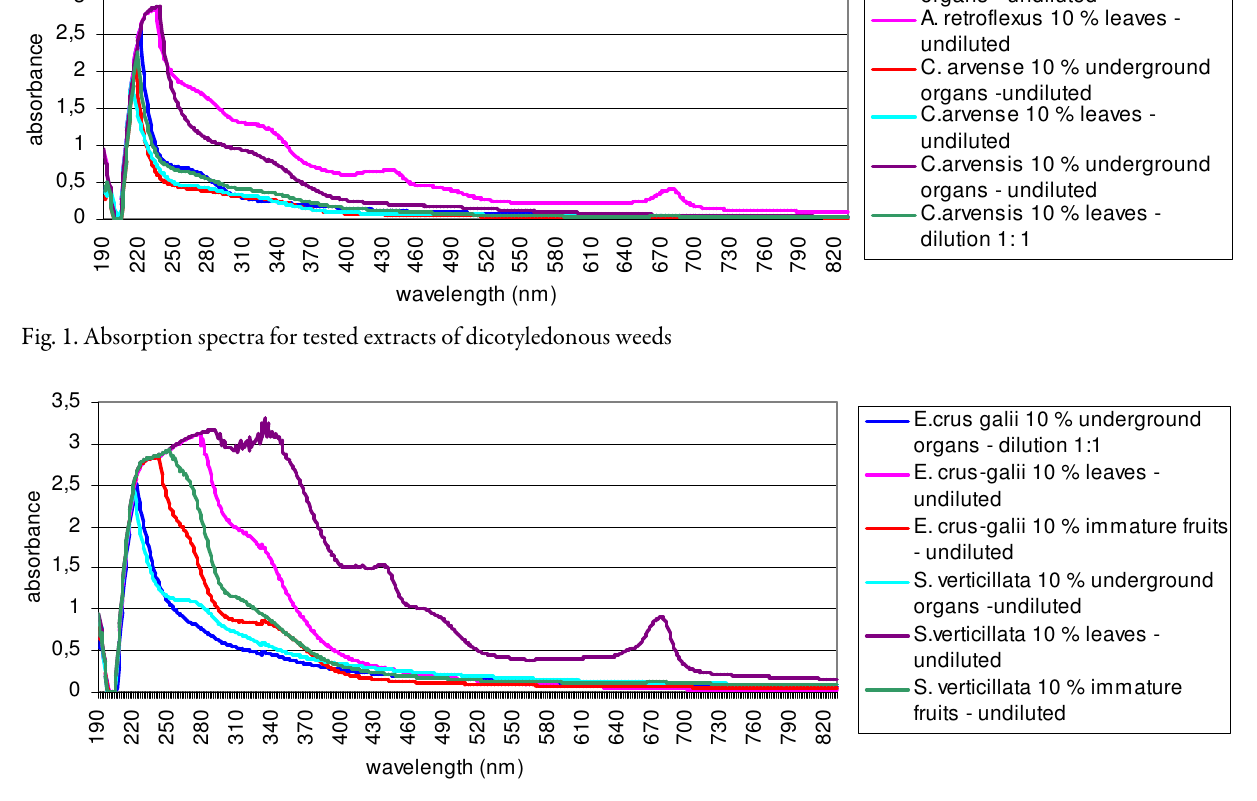
Fig. 2. Absorption spectra for tested extracts of monocotyledonous